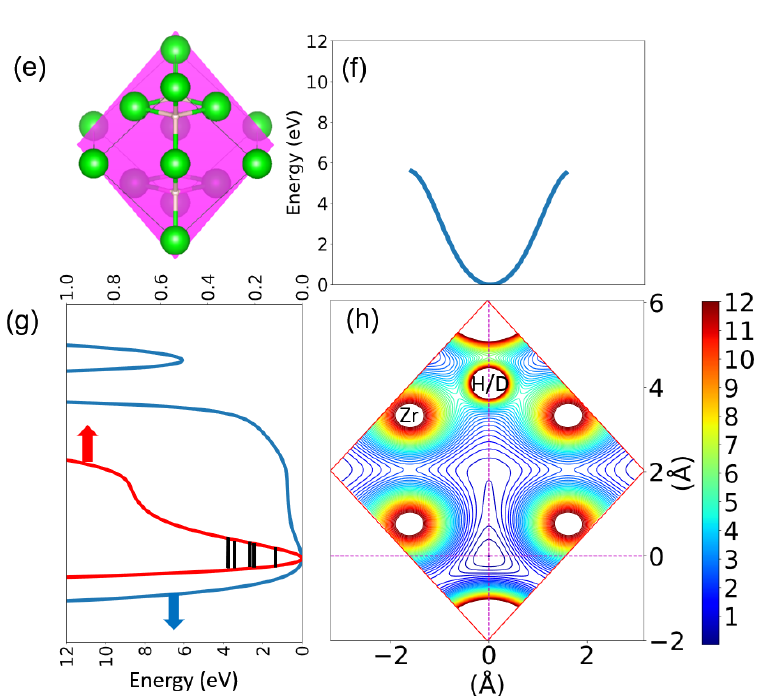
Figure 5. Crystal unit cells with sampling plane ( a , e ), contour plots ( d , h ) and sectional views of PES ( b , c , f , g ) for ZrH x . ( a – d ): plane (112) of (cid:101) -ZrH 2 ; ( e – h ): plane ( − 112) of γ -ZrH and γ -ZrD. Color scheme: Zr, green; H, white; sampling plane, pink. 50 equidistant energy levels within (0, 12) eV are used in contour plots, with minimum energies of 0 all located at (0, 0). Red lines in ( c , g ) are enlarged plots in vertical directions within the energy range of (0, 1) eV, and black lines indicate the lowest six eigenfrequencies (see Figure 6 for corresponding wavefunctions) from the Schrödinger equations of (cid:101) -ZrH 2 and γ -ZrD.